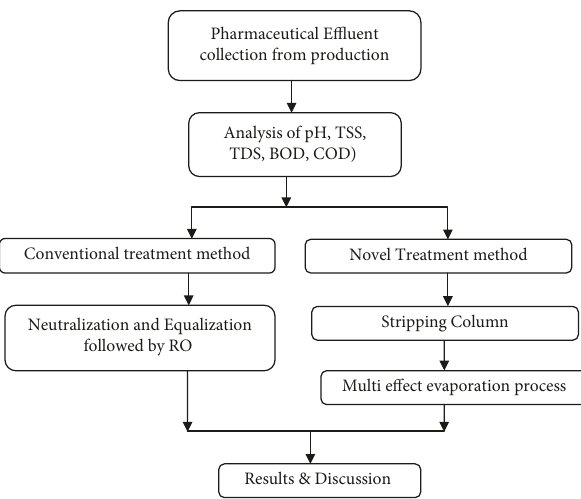
Figure 1: Flow diagram of